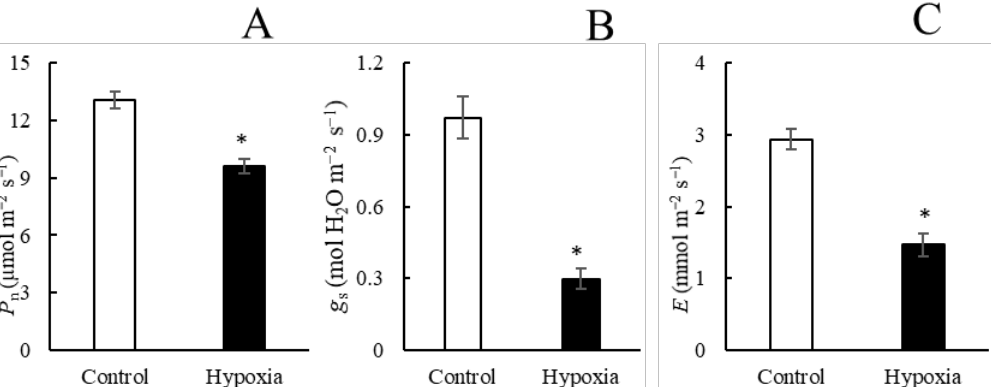
Figure 2. Net photosynthesis ( P n , A ), stomatal conductance ( g s , B ), and transpiration rate ( E , C ) in control plants and in plants subjected to hypoxia for three days. Means ± SE are shown ( n = 6 – 8). Asterisks indicate statistically significant differences between aerated and hypoxia ( p ≤ 0.05 denoted by *; t -test).